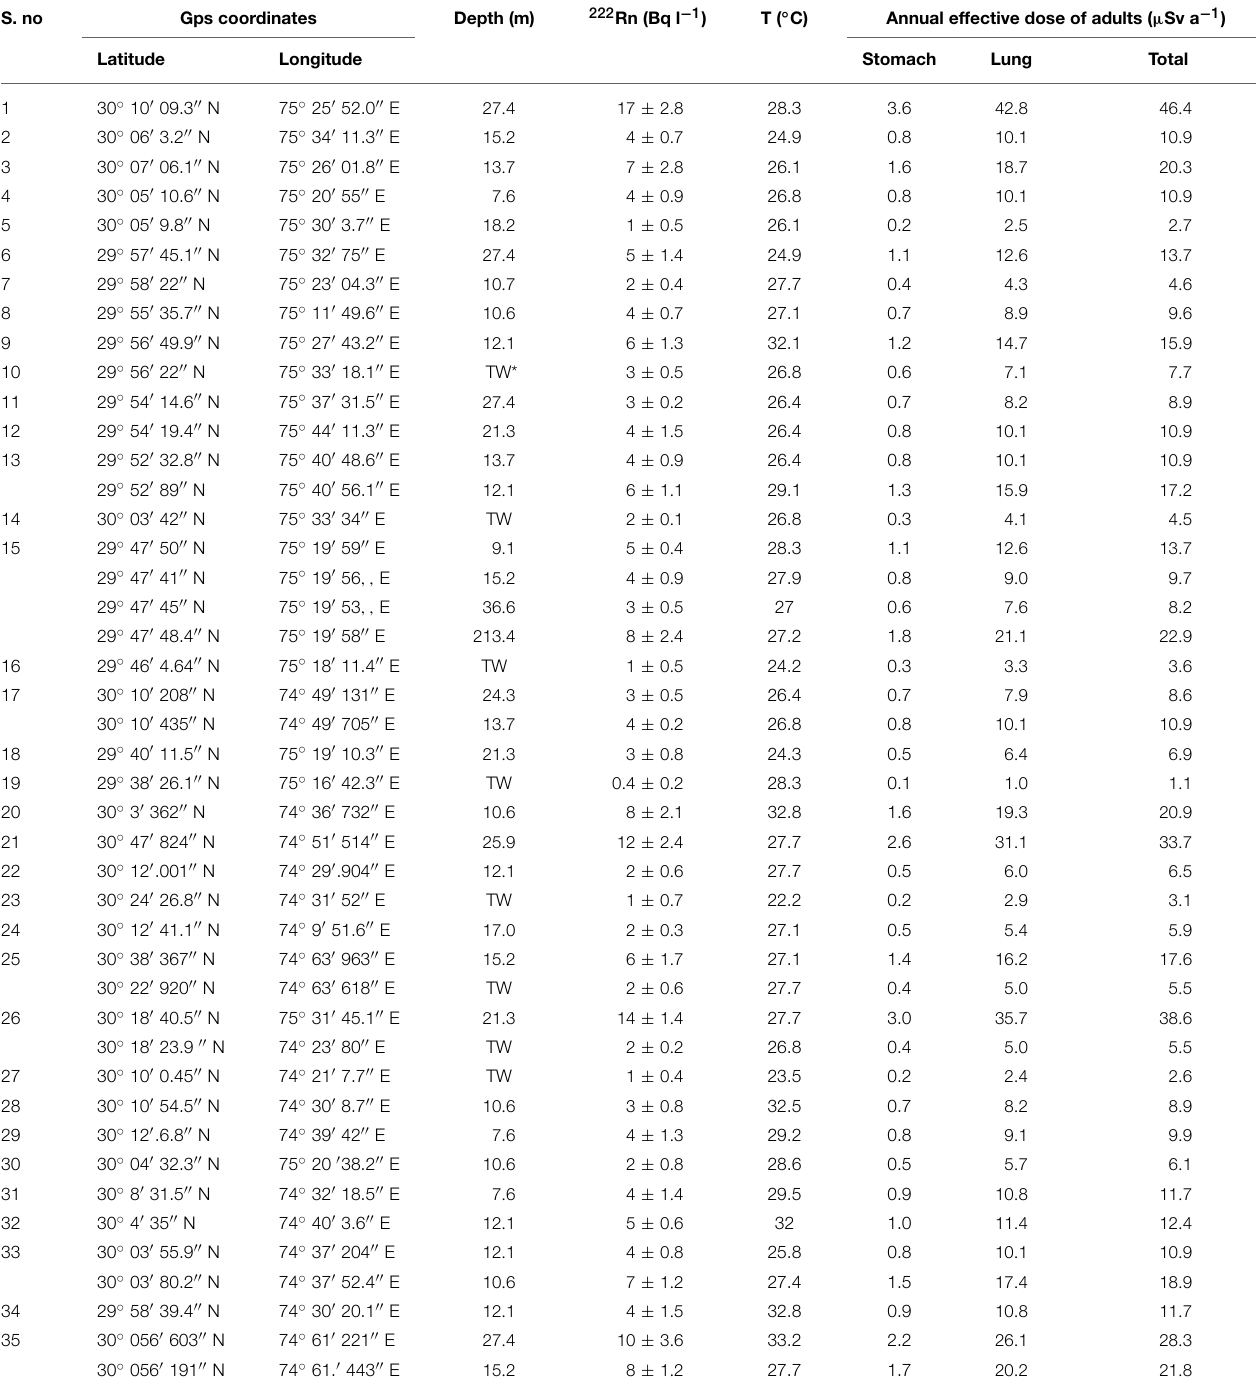
TABLE 1 | Average 222 Rn concentration data and annual effective dose of different water sources in Mansa and Muktsar Districts of